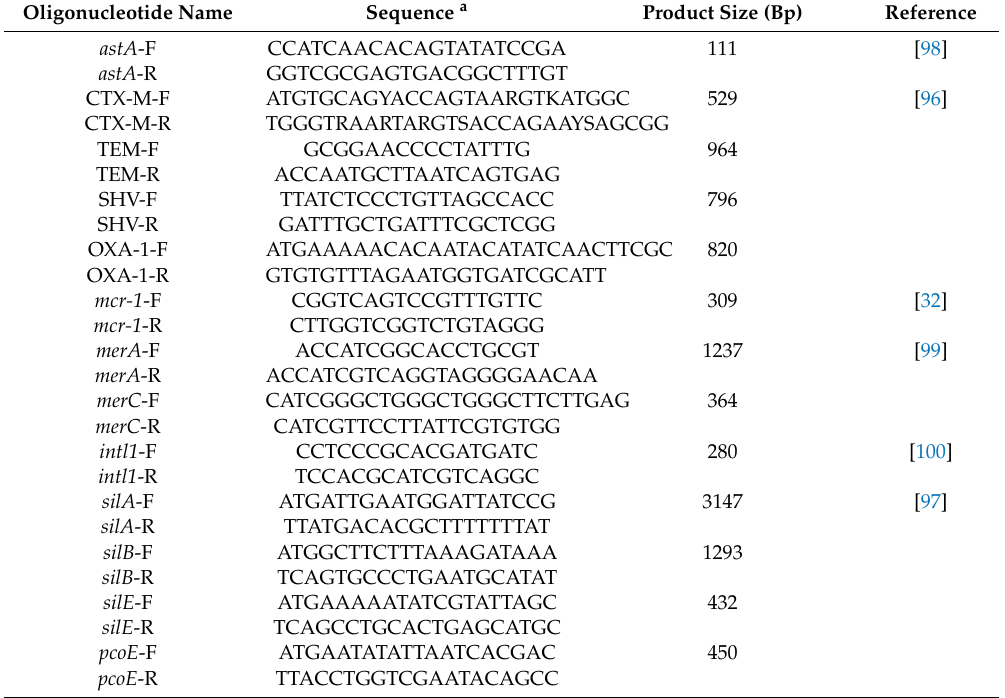
Table 4. Polymerase chain reaction (PCR) primers used for detection of β - lactamase genes and metal resistance genes.